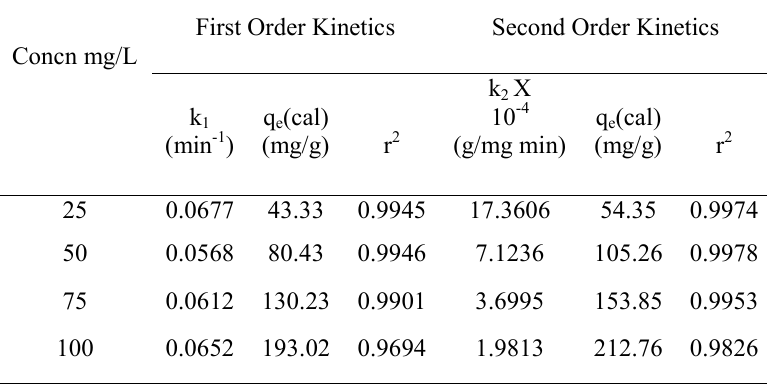
Table 2. Kinetic Model values for adsorption of Reactive